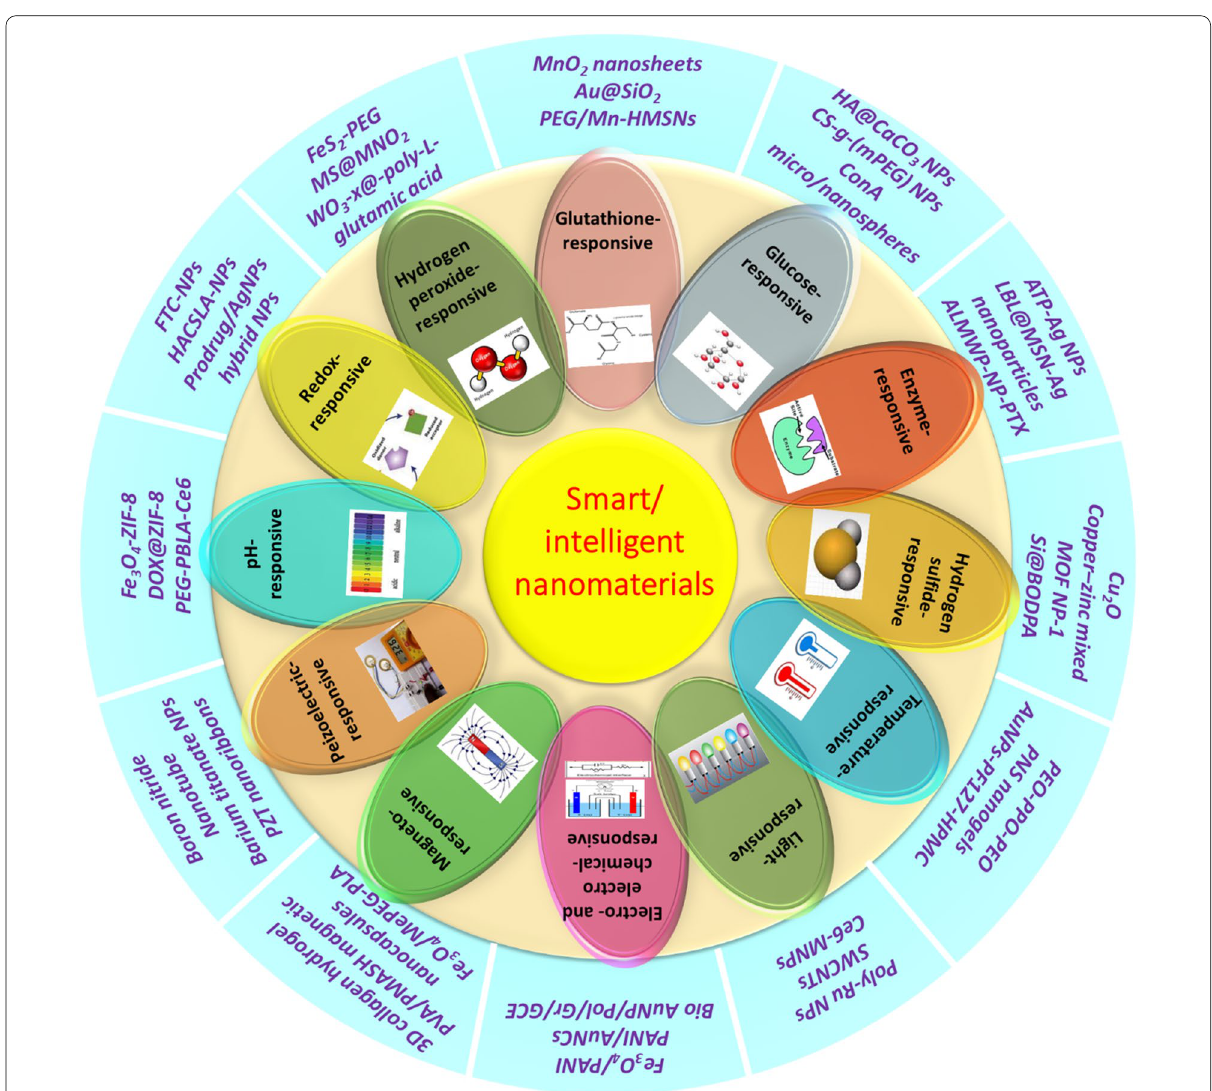
Fig. 1 Schematic representation of intelligent nanomaterial’s classification based on the specific stimulus and relevant